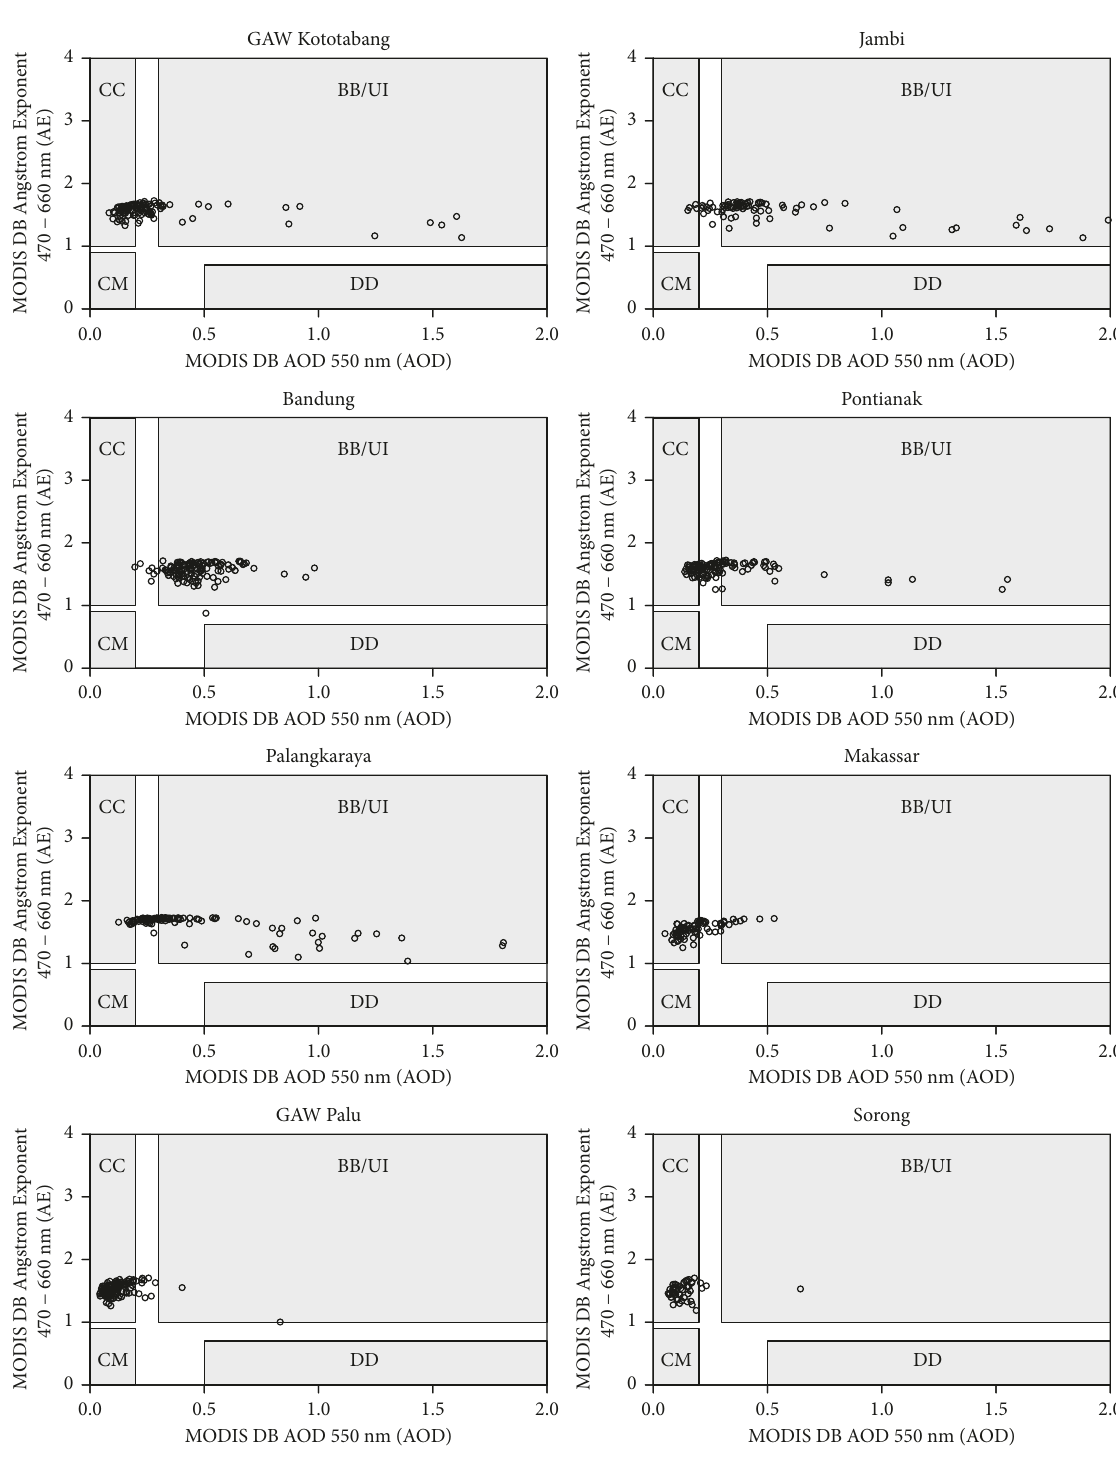
Figure 4: Relationship between monthly MODIS AOD 550nm and AE at AERONETsites over Indonesia from 2009 to 2019 according to aerosol classification in Table